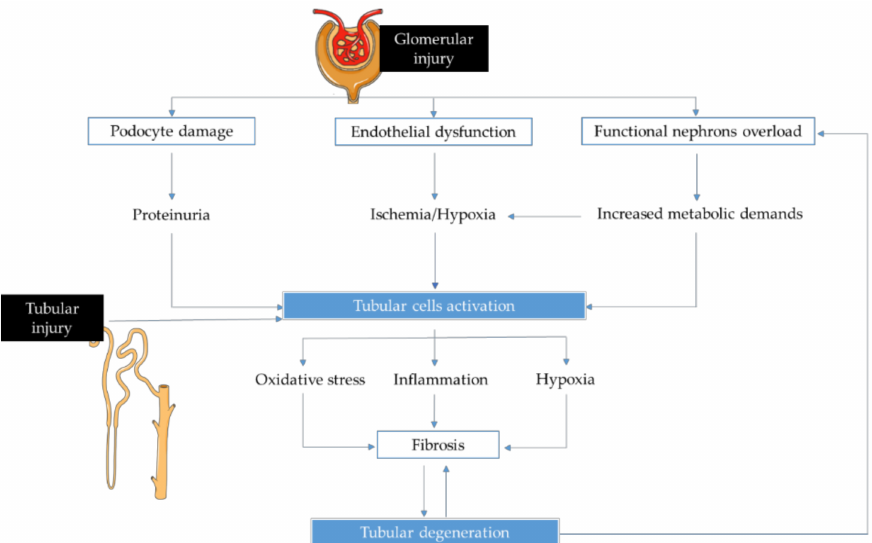
Figure 1. Mechanisms and related consequences of tubular cells activation, triggered by tubular and glomerular